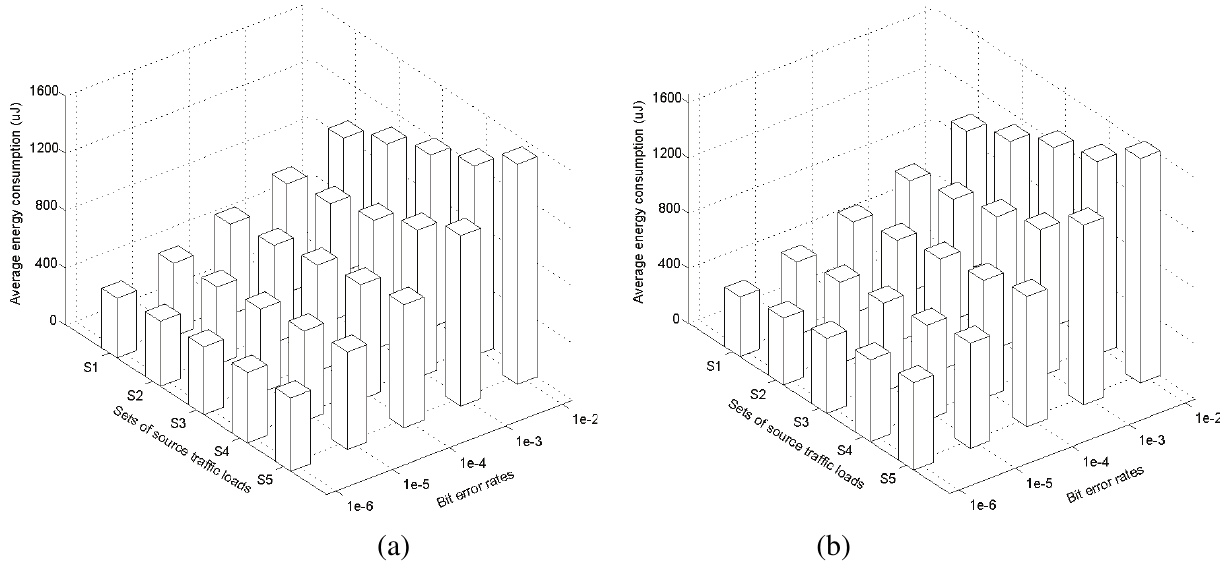
Figure 5. Average energy consumption per packet in (a) DMQoS and (b) DARA for varying traffic loads and bit error